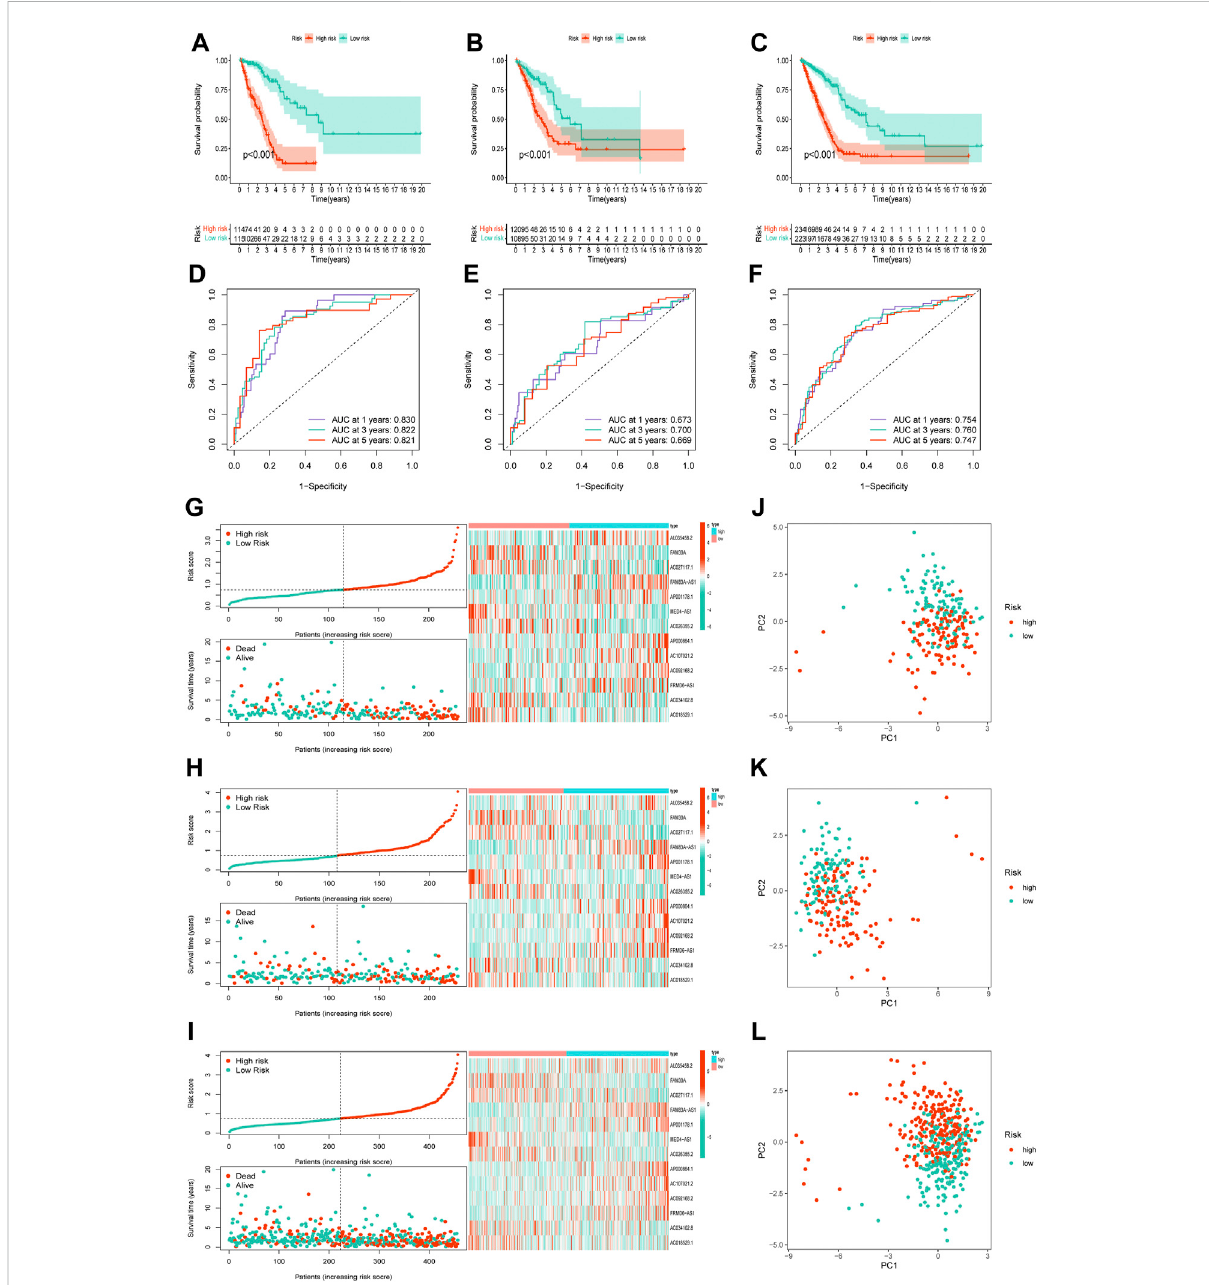
FIGURE 3 Validation of the necroptosis-related lncRNA prognostic signature. (A – C) The overall survival curves of high-risk and low-risk groups in the training, validation, and all cohorts. (D – F) The area under the curve (AUC) of the ROC curve shows the accuracy of the predictive survival signature. (G – I) The risk score and survival status distribution diagrams of the high-risk and low-risk groups. (J – L) Principal component analysis (PCA) of the high-risk and low-risk